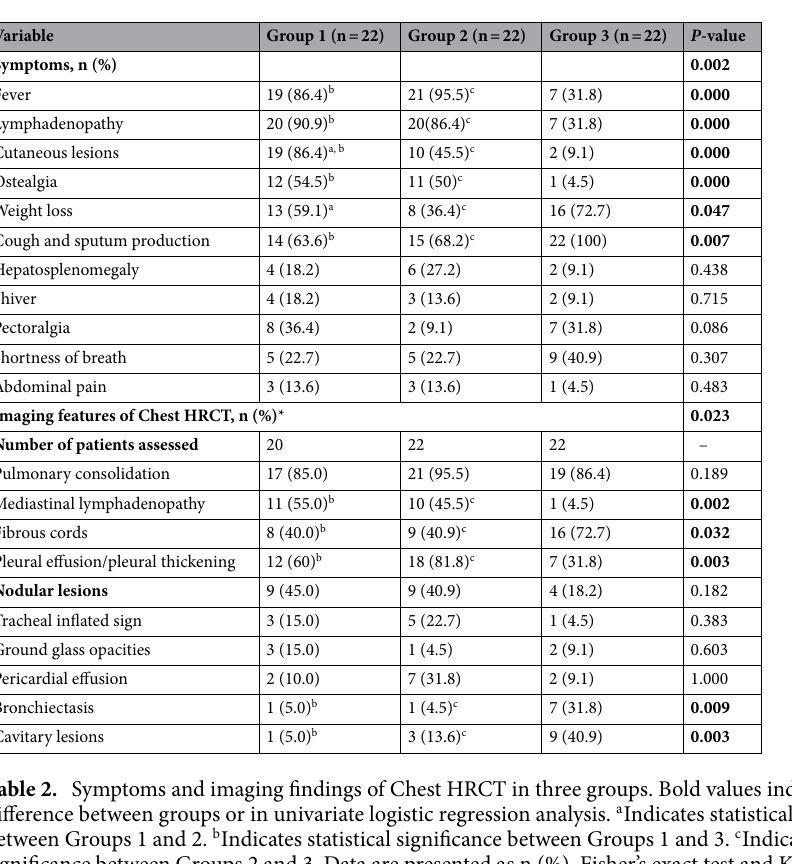
2 = patients with TM infections only, Group 3 = patients with NTM infections only. HRCT high resolution computed tomography. *Two patients from the systematic literature review did not undergo HRCT. Thus, a total of 20 patients received HRCT.